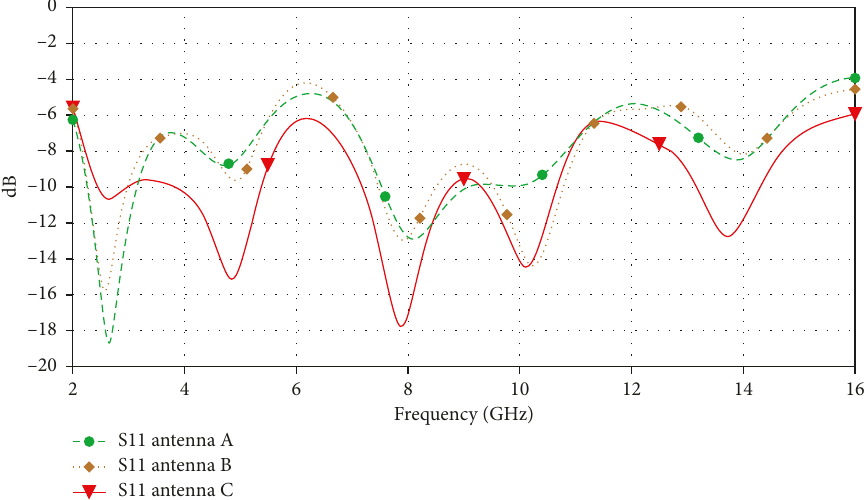
Figure 4: S 11 comparision plot-various stages of pentaband cross stub circular monopole